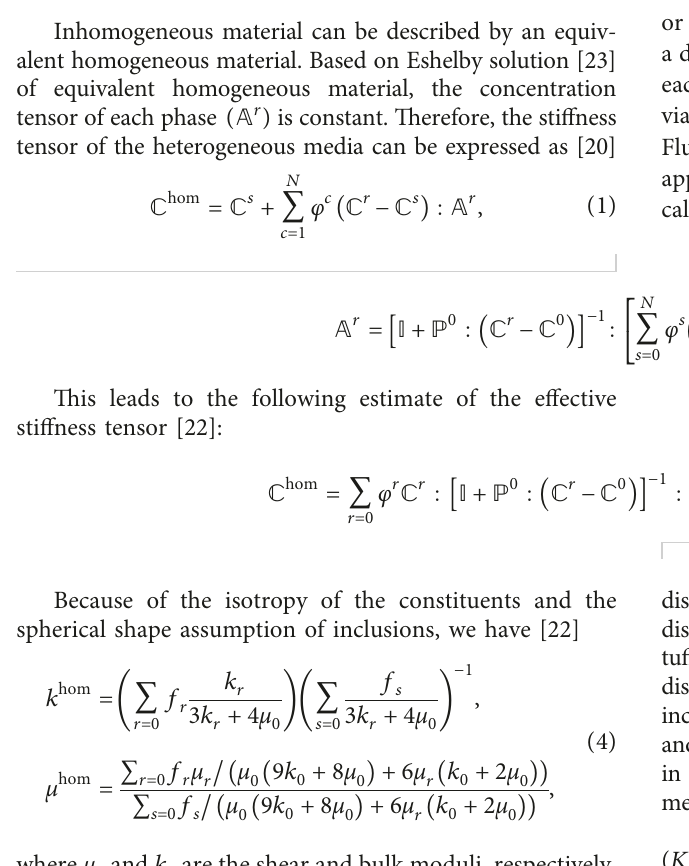
Figure 5: Homogenization and characteristic length scales